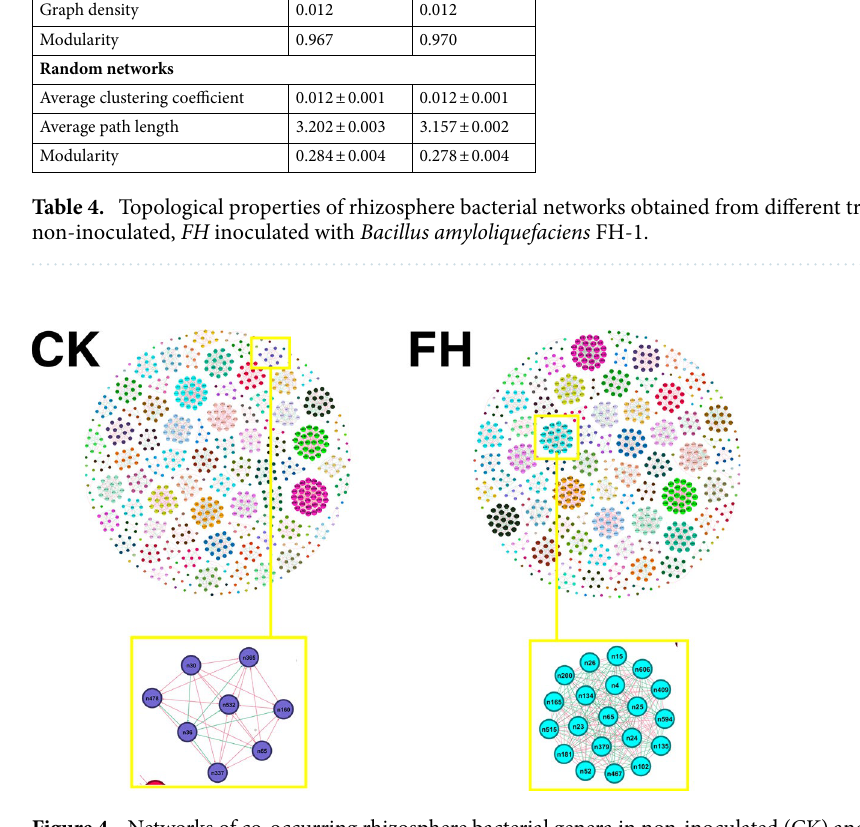
Figure 4. Networks of co-occurring rhizosphere bacterial genera in non-inoculated (CK) and Bacillus amyloliquefaciens FH-1 inoculated (FH) soil based on correlation analysis. A connection stands for a strong (Spearman’s r > 0.6) and significant ( P < 0.05) correlation. A blue edge indicates a negative interaction between two individual nodes, while a red edge indicates a positive interaction. The thickness of each connection between two nodes (i.e., edge) is proportional to the value of Spearman’s correlation coefficient. The co-occurring networks are colored by modularity class. The size of each node is proportional to the number of connections (i.e., degree). Bacillus is labeled